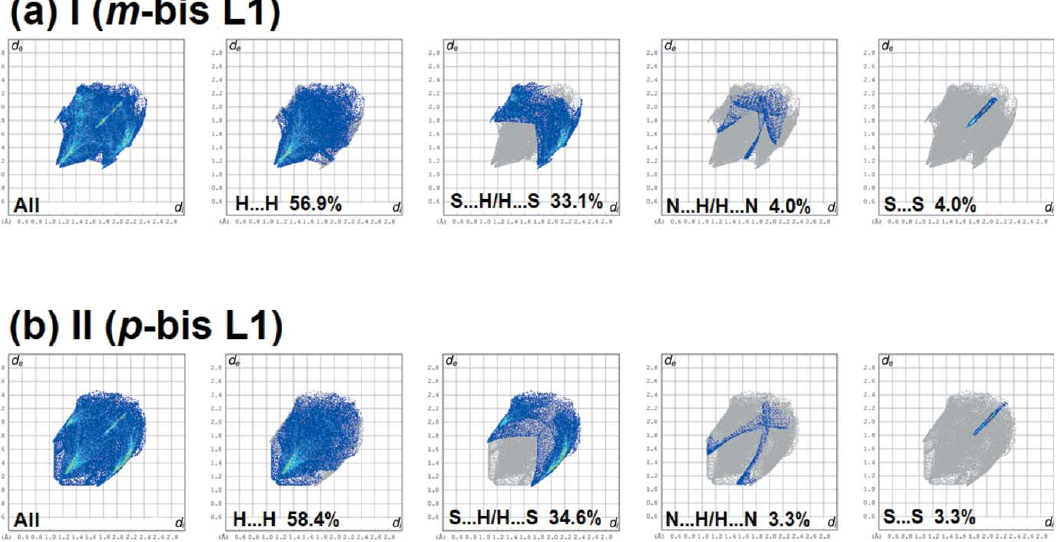
Figure 7 ( a ) The full two-dimensional fingerprint plot for I , and the fingerprint plots delineated into H (cid:2)(cid:2)(cid:2) H, S (cid:2)(cid:2)(cid:2) H/H (cid:2)(cid:2)(cid:2) S, N (cid:2)(cid:2)(cid:2) H/H (cid:2)(cid:2)(cid:2) N and S (cid:2)(cid:2)(cid:2) S contacts, ( b ) the full two-dimensional fingerprint plot for II , and the fingerprint plots delineated into H (cid:2)(cid:2)(cid:2) H, S (cid:2)(cid:2)(cid:2) H/H (cid:2)(cid:2)(cid:2) S, N (cid:2)(cid:2)(cid:2) H/H (cid:2)(cid:2)(cid:2) N and S (cid:2)(cid:2)(cid:2) S contacts.